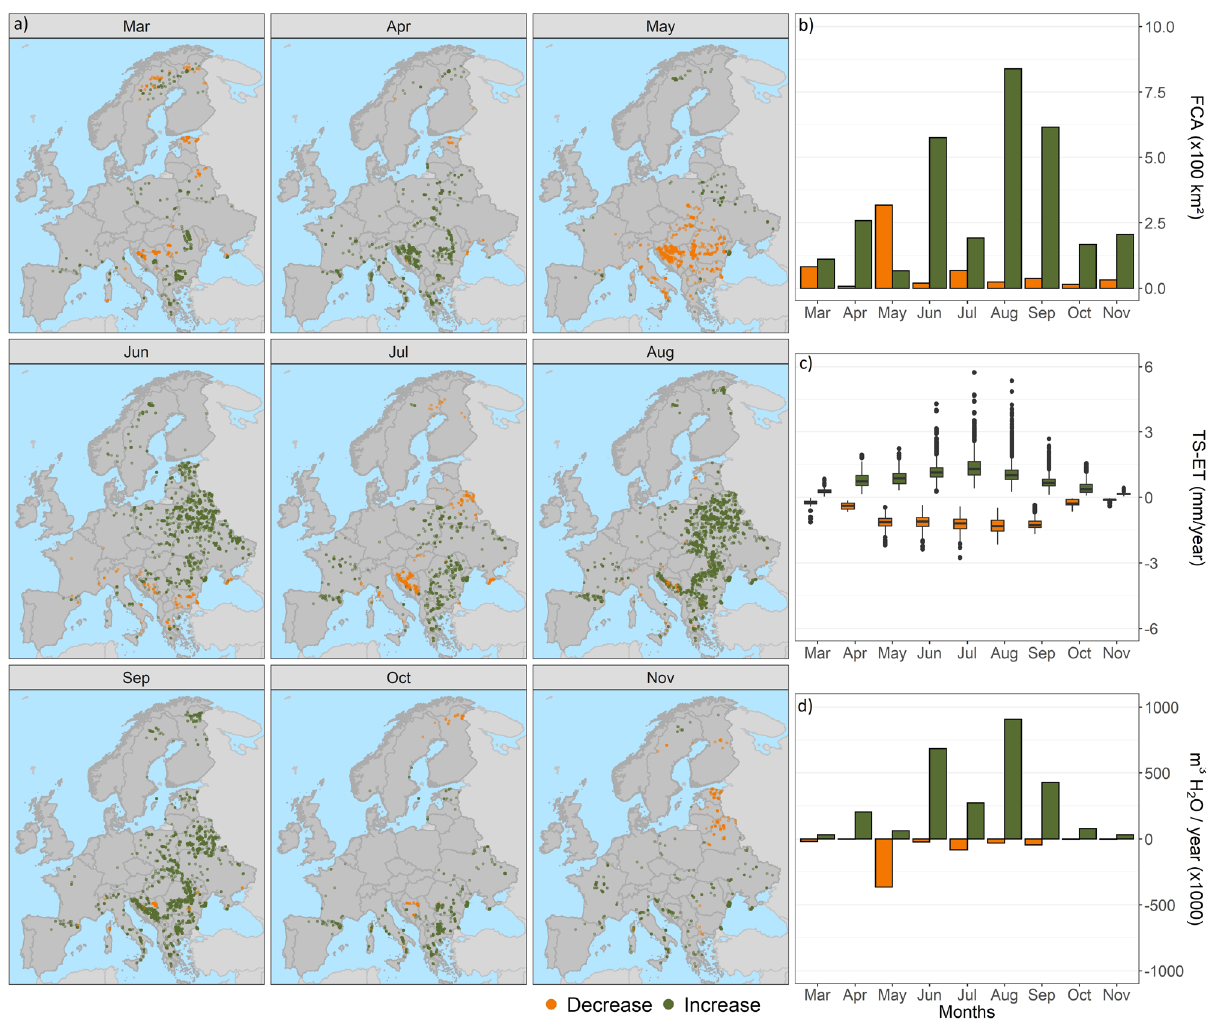
Fig. 3 Spatial and temporal dynamics of evapotranspiration over undisturbed forest core areas from 2000 to 2020. a Distributions of forest core areas (FCAs) with statistically signi fi cant ( p < 0.05) increasing or decreasing trends for monthly evapotranspiration (ET) from 2000 to 2020. b Total FCA area that showed a signi fi cant increase or decrease in ET. c Theil – Sen ’ s slope (TS) values for the increasing and decreasing ET trends at a monthly time scale. d Monthly total ET trend (increase and decrease). Signi fi cant trends were identi fi ed using the Mann – Kendal test for each